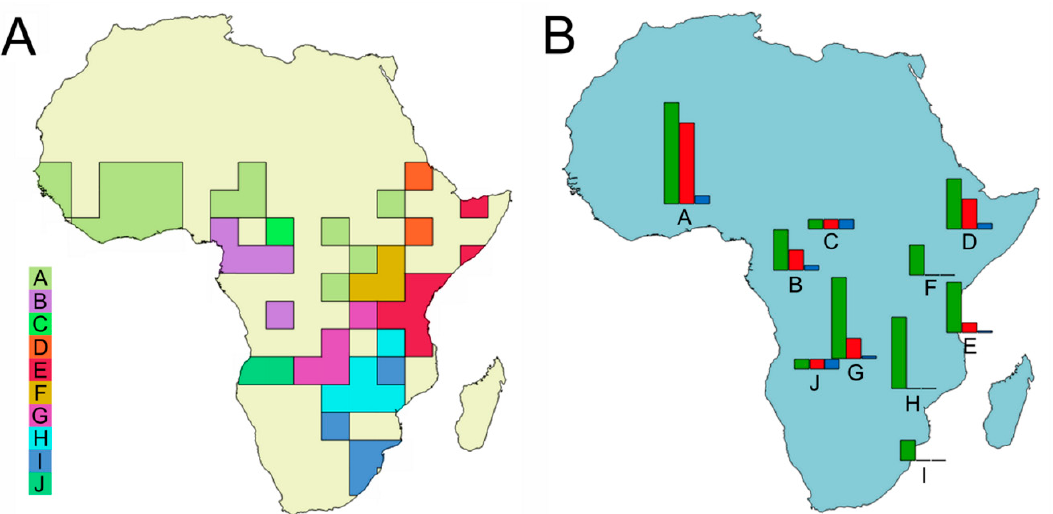
Figure 4. Results of the analysis by InfoMap. ( A ): Map of the 10 areas identified. ( B ): Map showing for each area (A–J) the total number of species (green bar), the number of endemic species (red bar), and the percent relative endemism (blue bar).